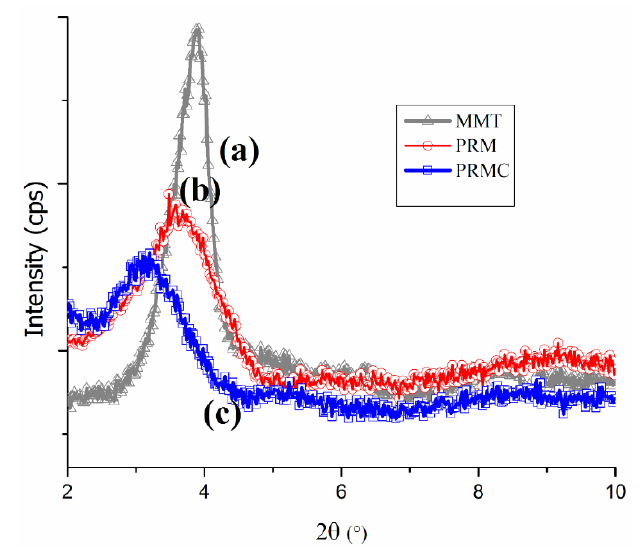
Figure 2. XRD diffractograms of ( a ) MMT, ( b ) PRM, and ( c ) PRMC. Figure 2. XRD di ff ractograms of ( a ) MMT, ( b ) PRM, and ( c )